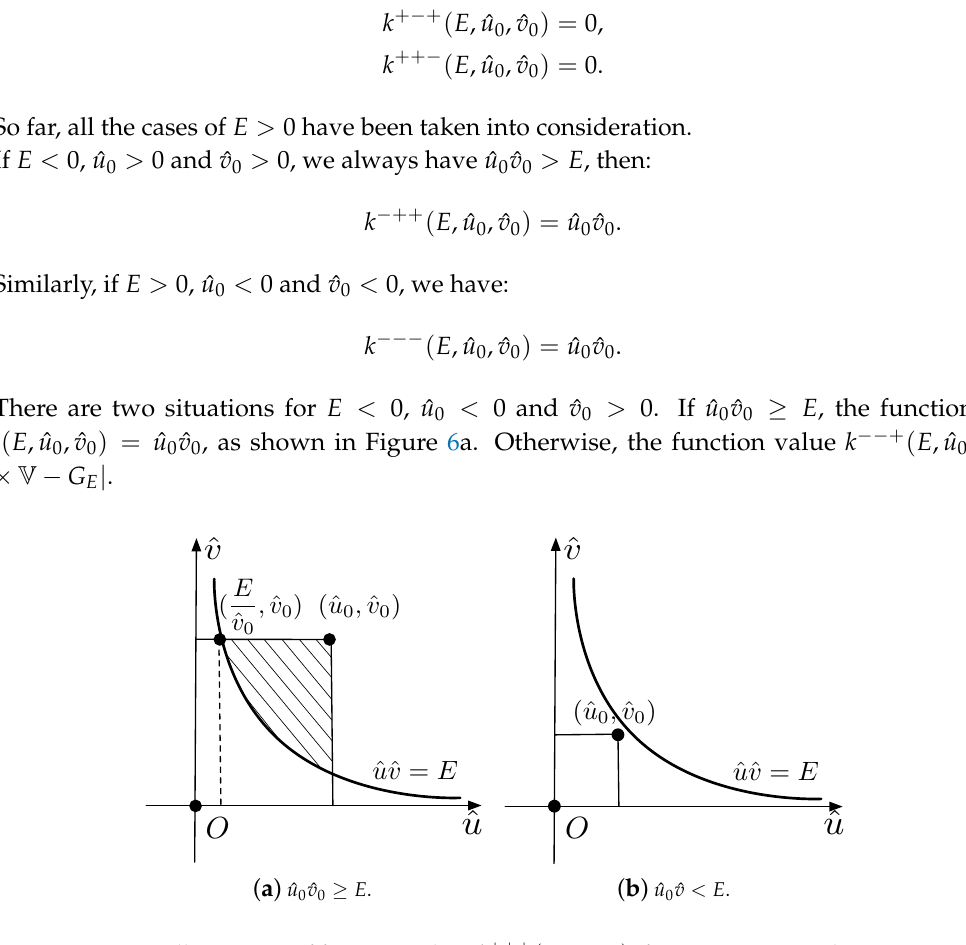
Figure 5. Illustrations of function values k +++ ( E , ˆ u 0 , ˆ v 0 ) if E > 0, ˆ u 0 > 0, and ˆ v 0 >